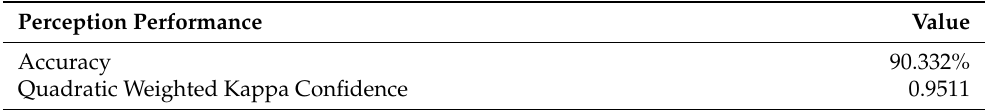
Table 3. The performance of the environmental